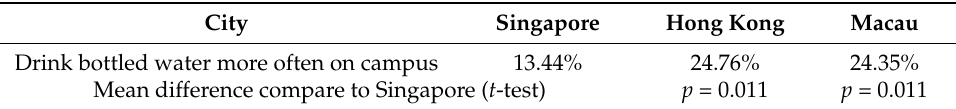
Table 2. Drinking water choice on campus by